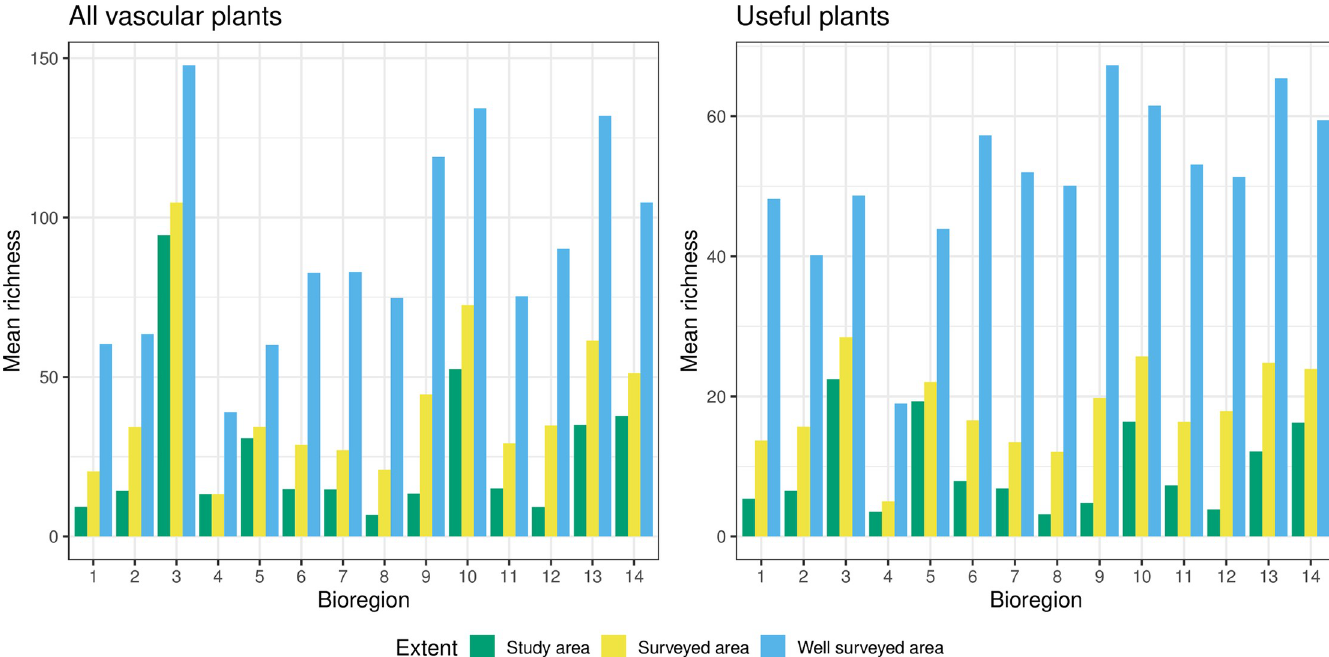
Fig 2. Mean species richness in the study area and in the surveyed areas: all vascular plants (A) and useful plants (B). Mean species richness in the study area was estimated as the number of species recorded in each 10 x 10 km grid cell within the geographic extent of Colombia; surveyed area richness was estimated within all 10 x 10 km grid cells with at least 1 record, and well surveyed area richness was estimated within all 10 x 10 km grid cells with � 25 records. See Fig 1 for bioregion names and S2.5 and S2.6 Tables in S2 File, for richness